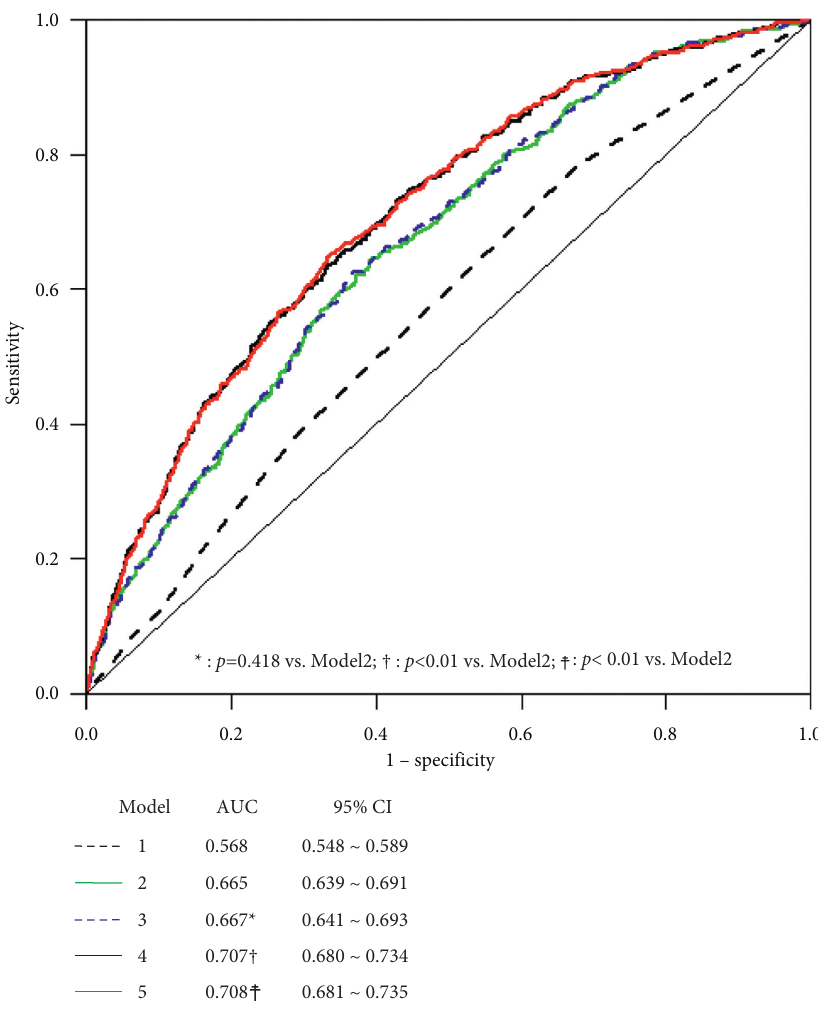
Figure 3: ROC curves for various models predicting incident hypertension.